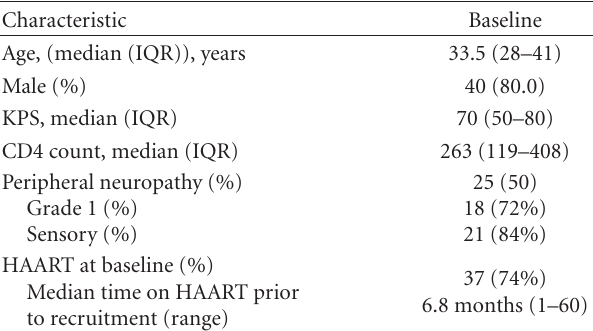
Figure 1: Progression-free survival (intention-to-treat analysis).